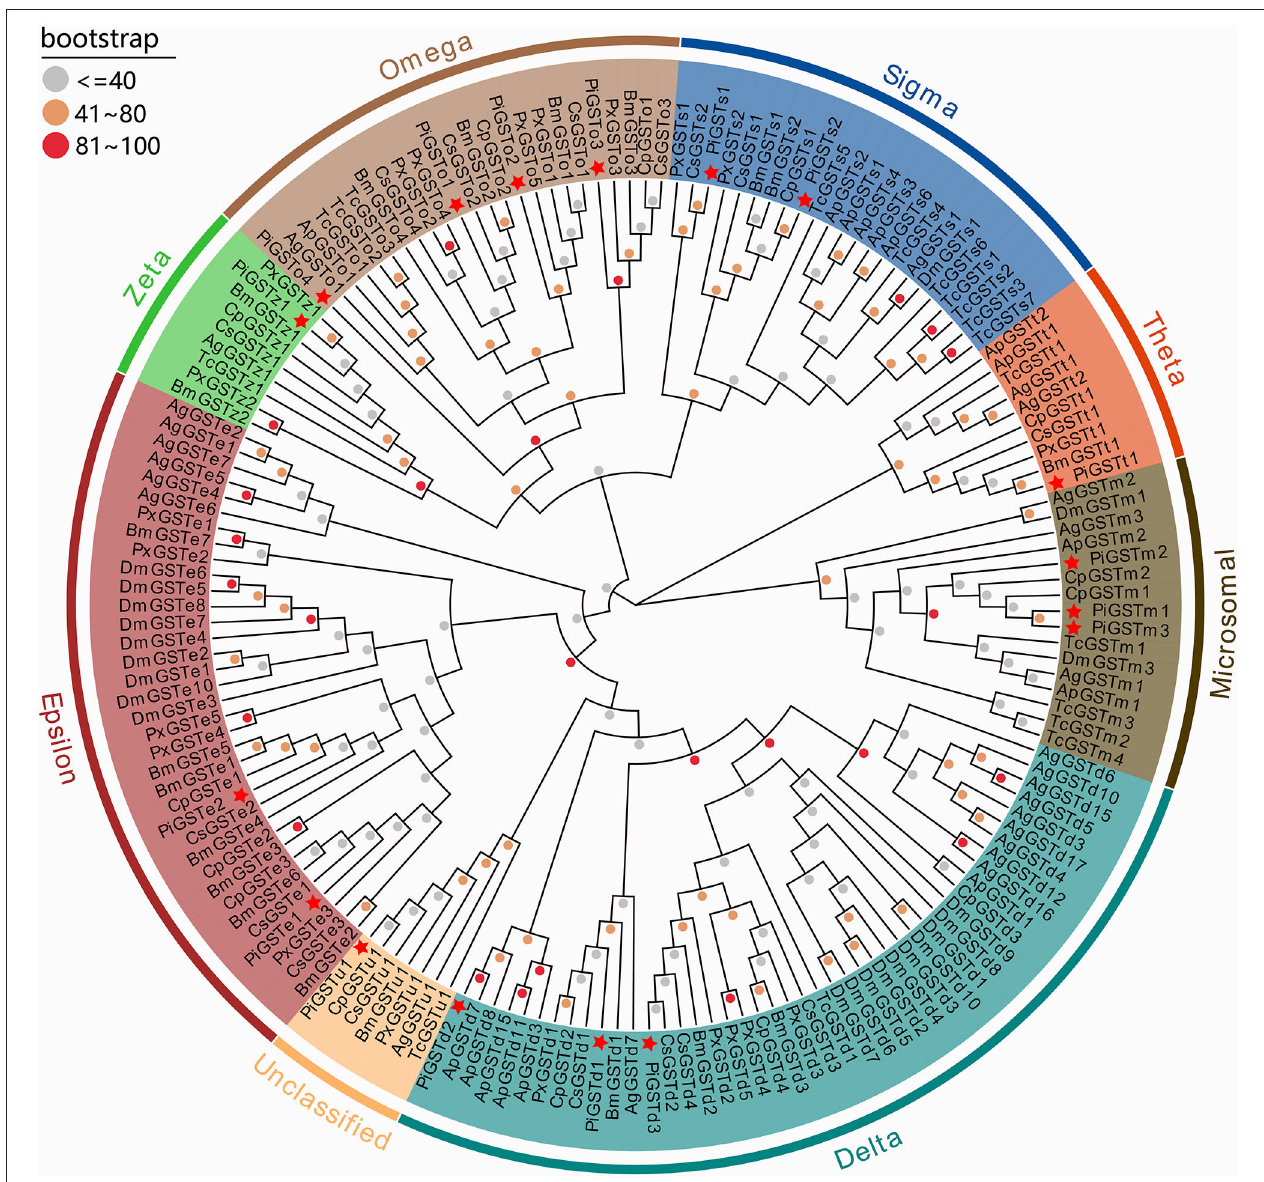
FIGURE 1 | Phylogenetic tree of GSTs from nine insect species. Eight GST branches are distinguished with different background color, and PiGSTs were marked with red stars. Dots with different colors present different bootstrap values: gray, ≤ 40; orange, 40–80; red, 81–100. Ag, Anopheles gambiae ; Ap, Acyrthosiphon pisum ; Bm, Bombyx mori ; Cs, Chilo suppressalis ; Cp, Cydia pomonella ; Dm, Drosophila melanogaster ; Pi, Plodia interpunctella ; Px, Plutella xylostella ; Tc, Tribolium castaneum .